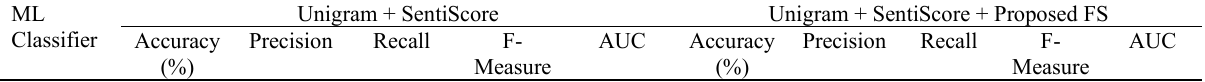
Table 6. Results of the proposed model for IMDB movie review data